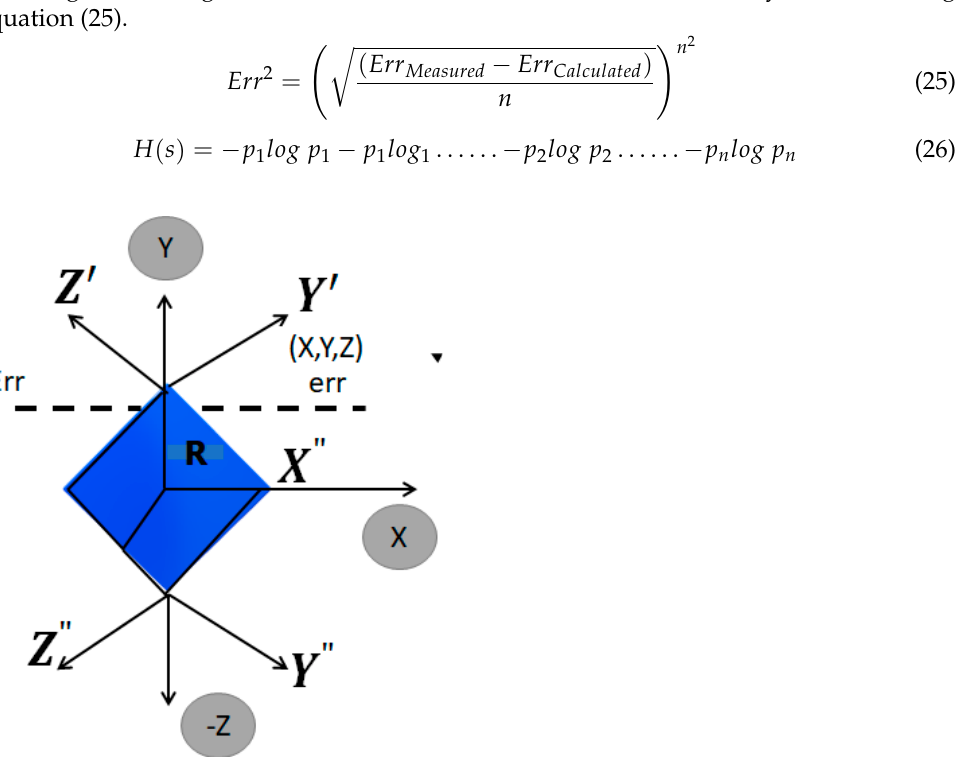
Figure 7. Blend minimization distance between two triangles using over-probability.